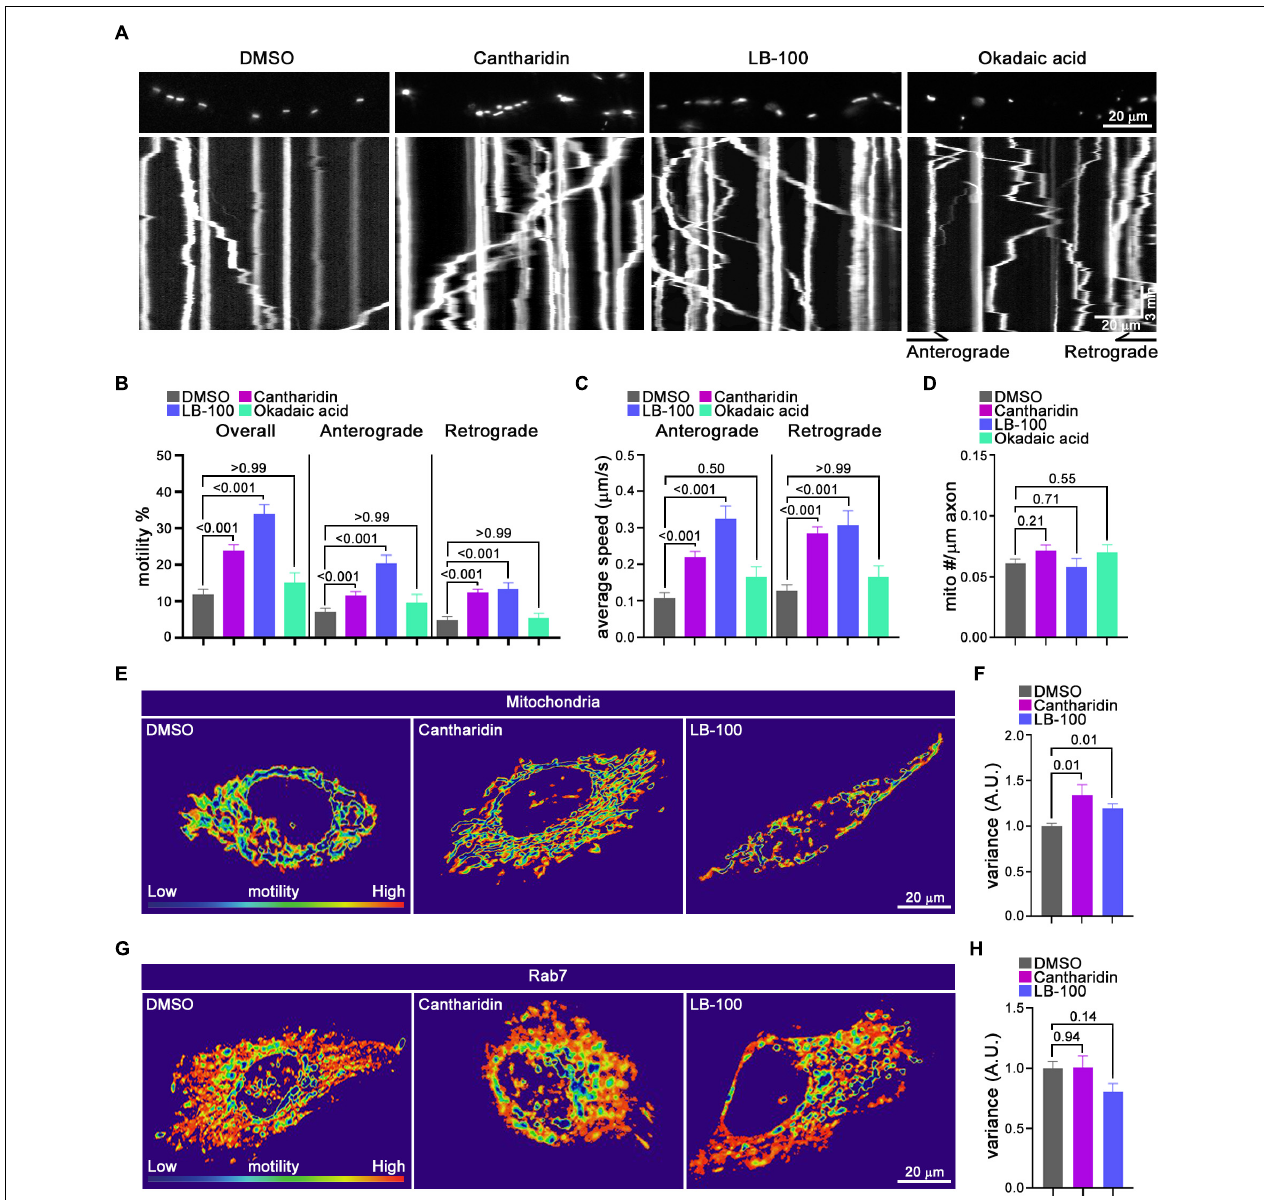
FIGURE 5 | Cantharidin and LB-100 increase both anterograde and retrograde mitochondrial transport. (A–D) Kymograph analysis of mitochondrial transport in axons of rat cortical neurons treated with DMSO, cantharidin, LB-100 and okadaic acid. (A) Representative images of axons with labeled mitochondria above kymographs derived from movies of those axons. The percent of mitochondria that were motile (B) , their average velocity in either direction (C) , and mitochondrial density along the axon (D) were derived from kymographs as in (A) . Statistical comparisons to the DMSO control were by nonparametric Kruskal–Wallis (B,C) , and one-way ANOVA (D) . The movement of mitochondria (E,F) or Rab7-tagged endosomes (G,H) in Hela cells as illustrated with heat maps generated in QuoVadoPro (E,G) and quantification of their motility (F,H) . The number of cells quantified for mitochondria: n = 20 (DMSO), n = 18 (Cantharidin), n = 10 (LB-100); for Rab7: n = 23 (DMSO), n = 15 (cantharidin), n = 12 (LB-100). The variance score was normalized to DMSO. Statistical comparisons are with nonparametric Kruskal–Wallis tests (F) and one-way ANOVA test (H) . All experiments were done in three independent cultures. A total of 35 axon segments (231 mitochondria) for DMSO, 40 axon segments (326 mitochondria) for cantharidin, 19 axon segments (152 mitochondria) for LB-100, and 11 axon segments (70 mitochondria) for okadaic acid treated neurons were analyzed. Each axon segment was selected from a separate neuron. Bars represent the average motility of all mitochondria analyzed for each condition. Error bars represent